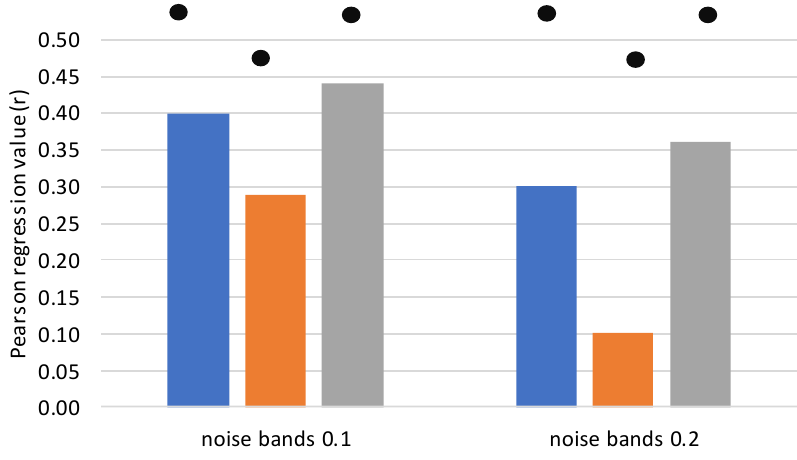
Figure 8. Pearson regression value ( r ) of the fusion between the noisy GPR depth slices (level of 0.1) and the noisy spectral bands (level 0.1 and 0.2) based on the Bayesian Neural Network. GPR depth slice of 0.00–0.20 m is shown with blue color, depth slice of 0.20–0.40 m with an orange color and depth slice 0.40–0.60 m depth slice with a gray color. Correlation achieved with the noiseless dataset is shown with dots for each depth slice.